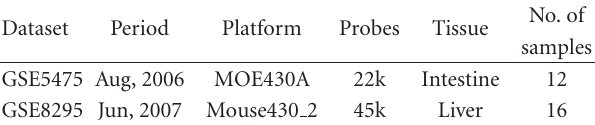
Table 1: Summary of re-analyzed